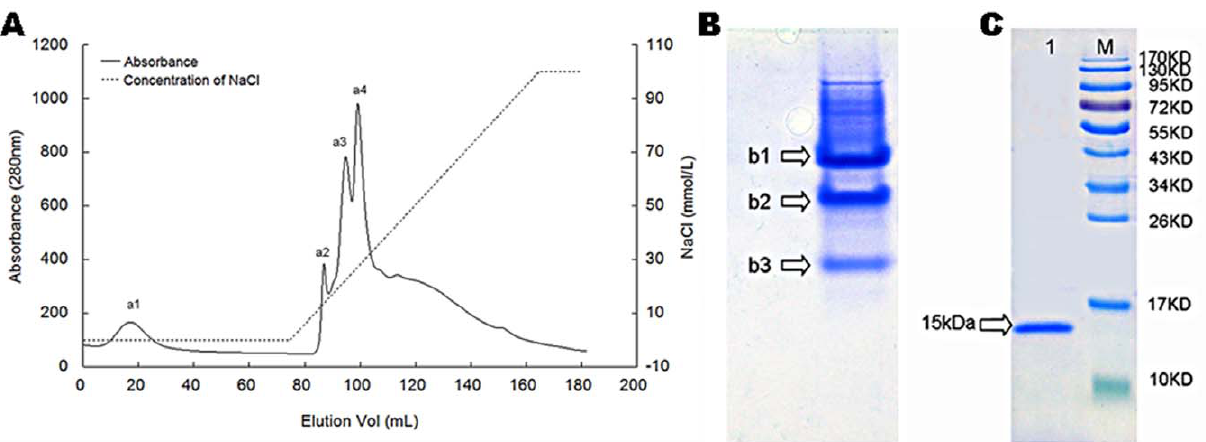
Figure 1. The purification of MoHrip1 from M.oryzae . A . Concentrated culture filtrate was loaded on HiTrap TM Q HP 5 ml column at a flow rate of 2 ml/min. Four peaks were collected, and the target protein was included in peak a2. B . Peak a2 was pooled and applied to native-PAGE and electroelution. The b3 fraction was the target elicitor protein. C . SDS-PAGE analysis of the purified elicitor protein, MoHrip1, showing a single band with Coomassie Brilliant Blue R-250 staining. ( 1 : MoHrip1, M : protein molecular weight marker). doi:10.1371/journal.pone.0037654.g001 cell culture (Figure 4B). H 2 O 2 was detected by 3,3 9 -diaminoben- zidine (DAB) staining, and sites of H 2 O 2 accumulation were clearly observed in the veins and stomata of tobacco leaves under